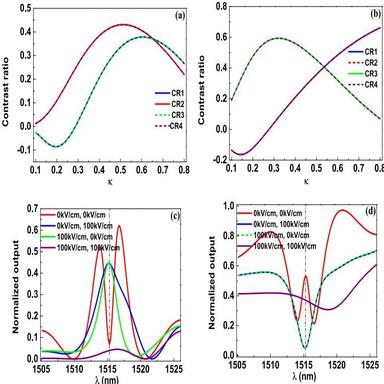
Coupling and wavelength dependency of the EA MRR and U-bent waveguides-based XOR and XNOR gates at F = 100 kV/cm. The dotted straight line indicates λR = 1515.27 nm. (a) CR at T port of Ring2 versus the coupling coefficient at λR = 1515.27 nm, (b) CR at D port of Ring2 versus the coupling coefficient at λR = 1515.27 nm, (c) Normalized T port power of Ring2 versus wavelength at various operands (fields applied on the rings) and κ = 0.6, (d) Normalized D port power of Ring2 versus wavelength at various operan